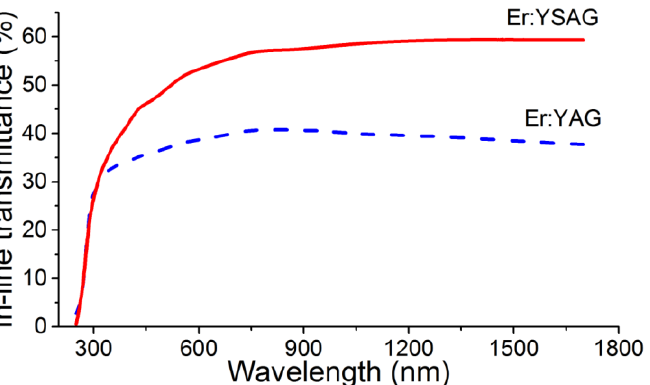
Figure 4. In-line transmittance of the Er 3+ :YAG (blue) and Er 3+ :YSAG (red) samples.